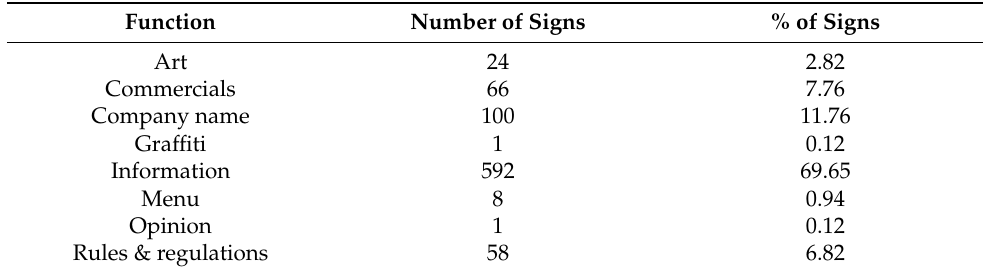
Table 2. Function of signs (N = 850).